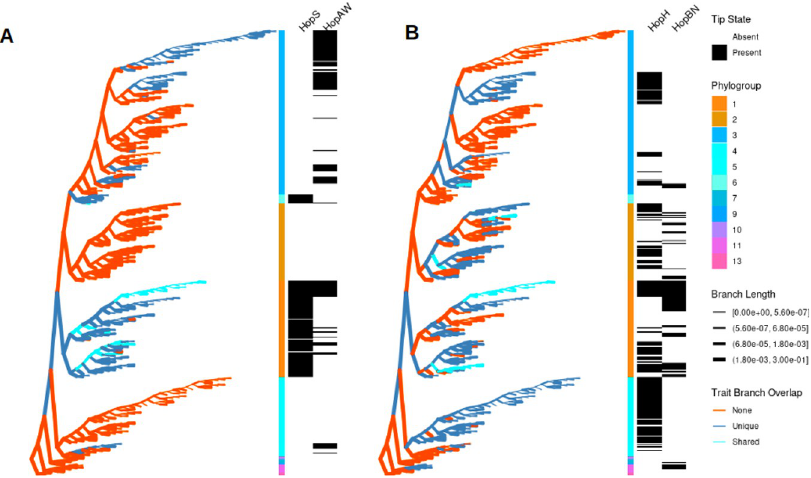
Fig 7. RecPD gene lineage reconstructions reveal significant differences in evolutionary histories between effector families of similar prevalence and phylogenetic diversity. Example pairs of effector family distributions mapped onto the P . syringae core-genome phylogeny. (A) Effector families HopS and HopAW show similar prevalence (HopS = 114 and HopAW = 116) but different RecPD values (HopS = 0.399 and HopAW = 0.198). (B) Effector families HopH and HopBN show different prevalence HopH = 206 and HopBN = 78) but similar RecPD values (0.16). Tree topologies are represented in a ‘willow tree’ format, with branches set to equal length, and actual branch-lengths indicated by branch-thickness. Branches are coloured according to overlap between RecPD-inferred gene family lineages.